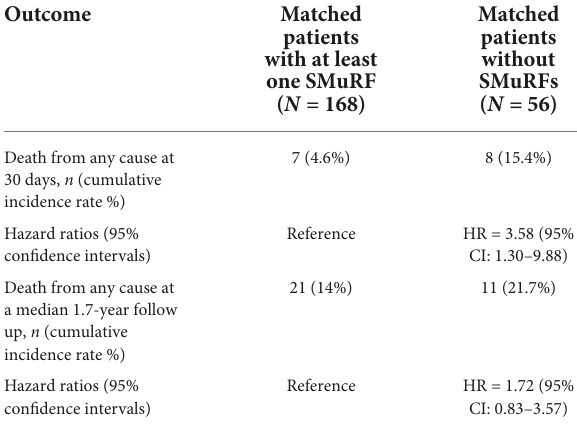
TABLE 3 Clinical follow-up outcomes according to zero or ≥ 1 standard modifiable risk